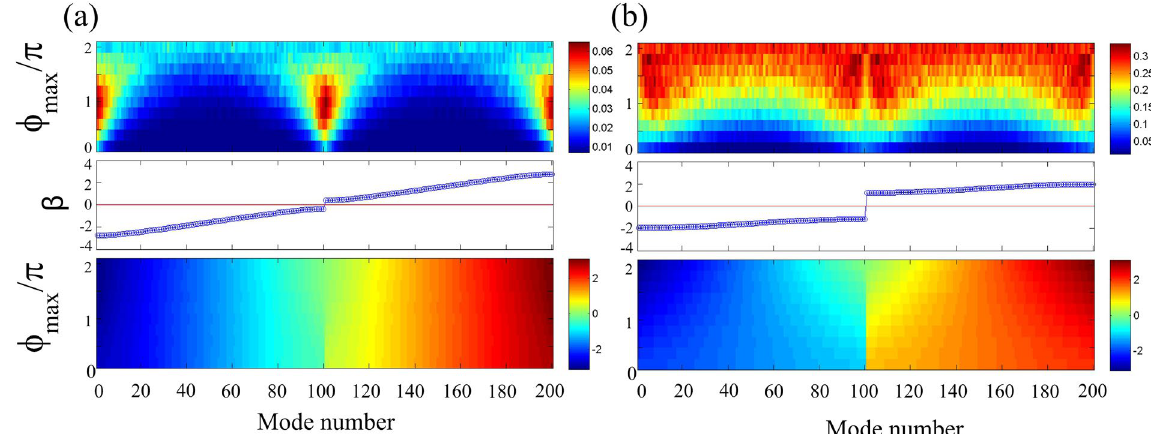
Figure 5. Inverse participation ratio for modes (upper panels) and the corresponding propagation constants β (lower panels) vs. the disorder strength ( φ max ) for different coupling ratios: ( a ) η = π /8 and ( b ) η = 3 π /8. Middle panels show the mode band structure for a trivial potential with φ max =